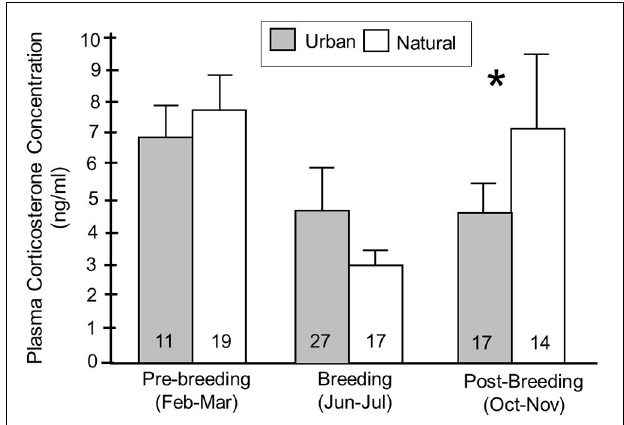
FIGURE 5 | Baseline corticosterone concentrations (means ± SE) in birds captured in urban and natural habitats, split according to whether birds were captured in the pre-breeding (February-March), breeding (June-July), or post-breeding (October-November) seasons. Fisher’s PLSD post hoc analyses were used to examine whether corticosterone concentrations were significantly different between habitats in each of the seasons. Habitats were classified based on behavior of birds at that site, particularly the likelihood that a bird exhibited evidence of habituation to humans at that site. Numbers in the bars indicate sample sizes and an asterisk indicates that values were significantly different between urban and natural habitats.